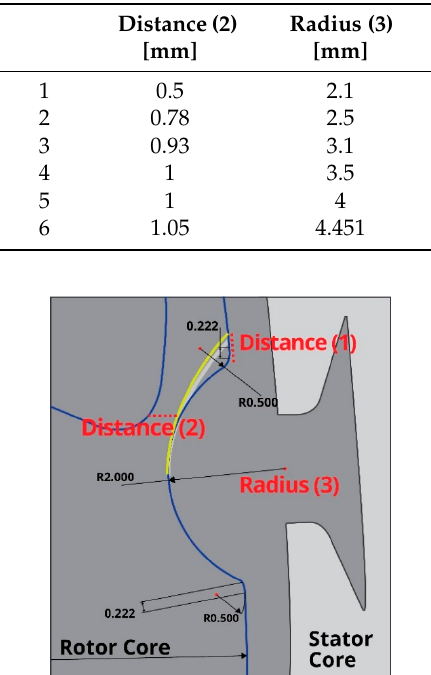
Figure 8. Notch optimization diagram with length parameter. Energies 2018 , 11 , x FOR PEER REVIEW